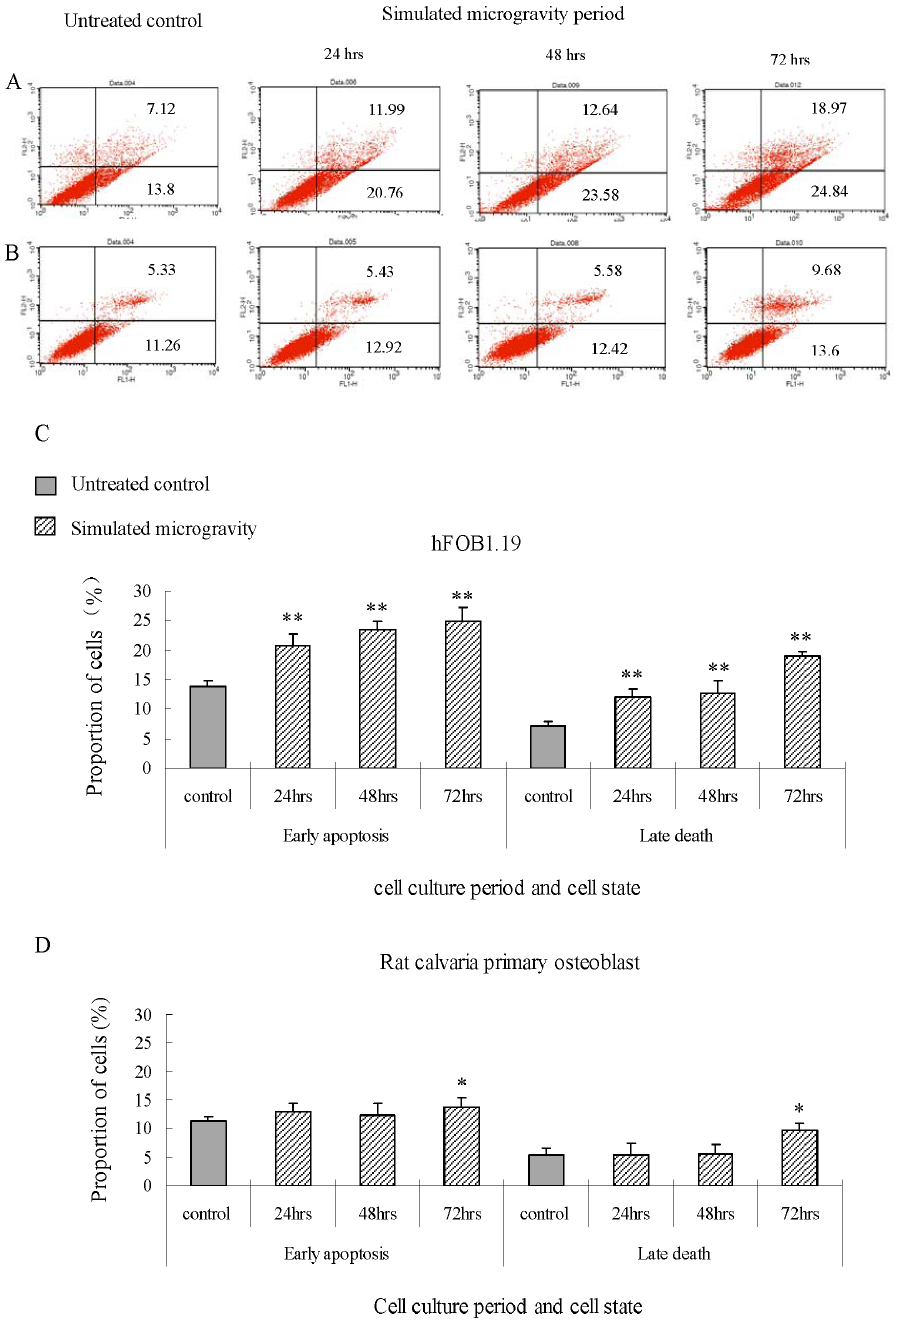
Figure 4. Apoptosis of hFOB1.19 cells and rat calvaria primary osteoblast under simulated microgravity. In hFOB1.19 cells (A and B), early apoptosis and late death mean extremely significant differences between untreated control and simulated microgravity for 24–72 hours. In rat calvaria primary osteoblasts (C and D), early apoptosis and late death mean significant differences between untreated control and simulated microgravity for 72 hours.The data shown represent the mean 6 S.E. (n=3). *0.01 , P , 0.05, and ** P , 0.01 ( t -test as compared to untreated control group).